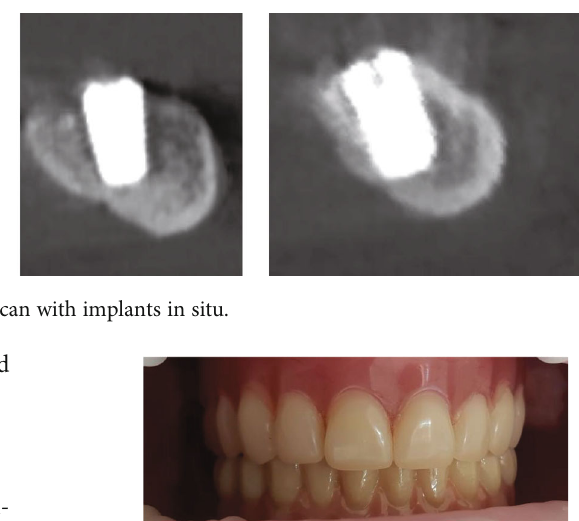
Figure 7: Removablemaxillary-andimplant-supportedmandibular prosthesis in situ.